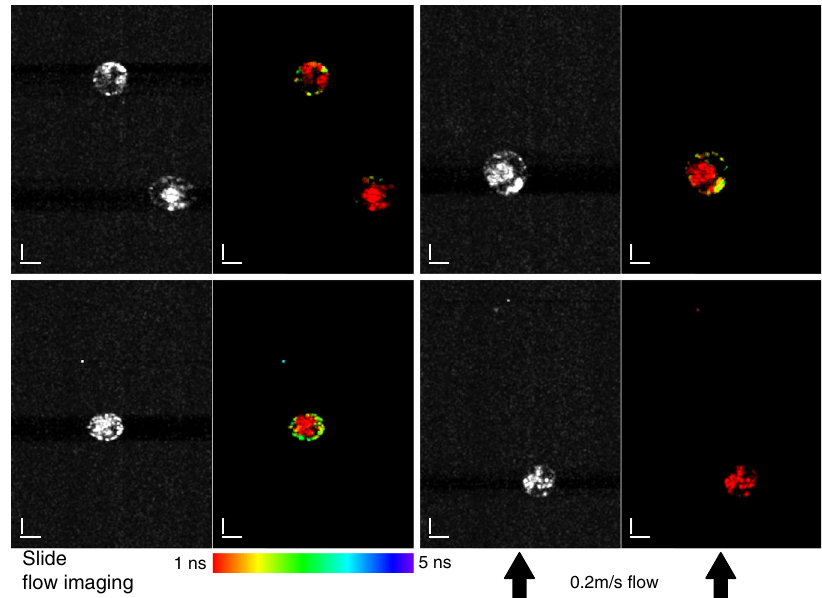
Fig. 5 SLIDE Lifetime Imaging fl ow cytometry of Euglena gracilis algae cells at 0.2 m/s fl ow speed. The Nile Red stained lipids can be clearly distinguished from the auto fl uorescent chloroplasts by their longer fl uorescent lifetime (~5 ns and ~1 ns, respectively, cf. Fig. 3), even at these high fl ow